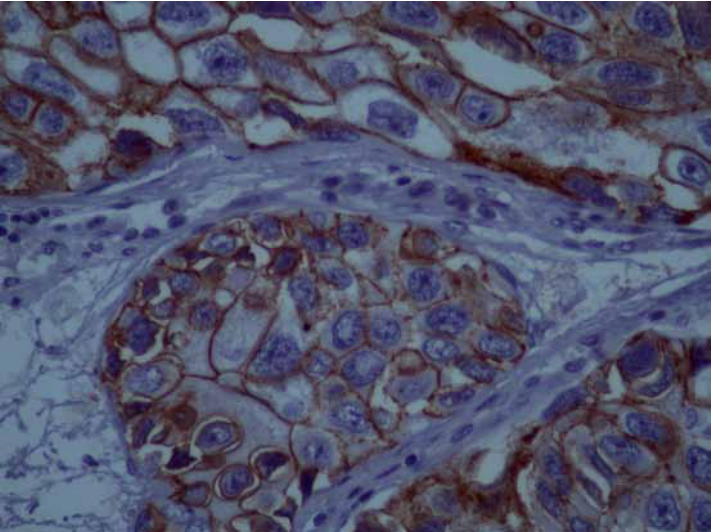
Figure 2 - Micrography of an IHc reaction showing strong expression of